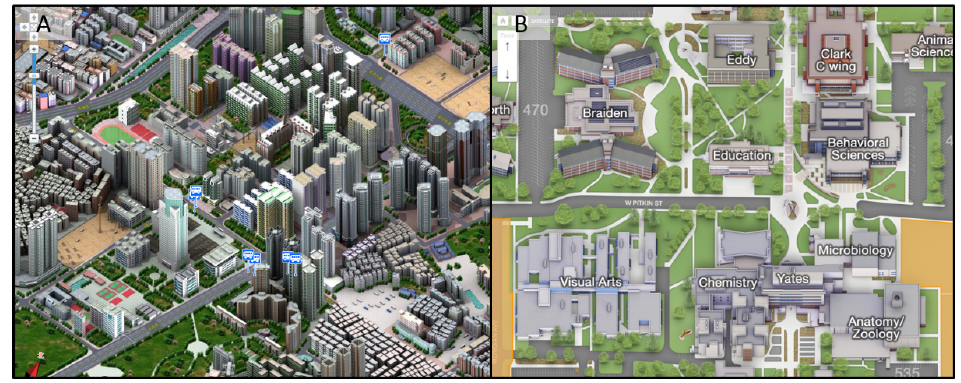
Figure 2. Application of 2.5D maps in ( A ) a web-based urban GIS (http://sz.edushi.com/); ( B ) an online campus GIS (http://maps.colostate.edu/) for efficient streaming of 3D city models.